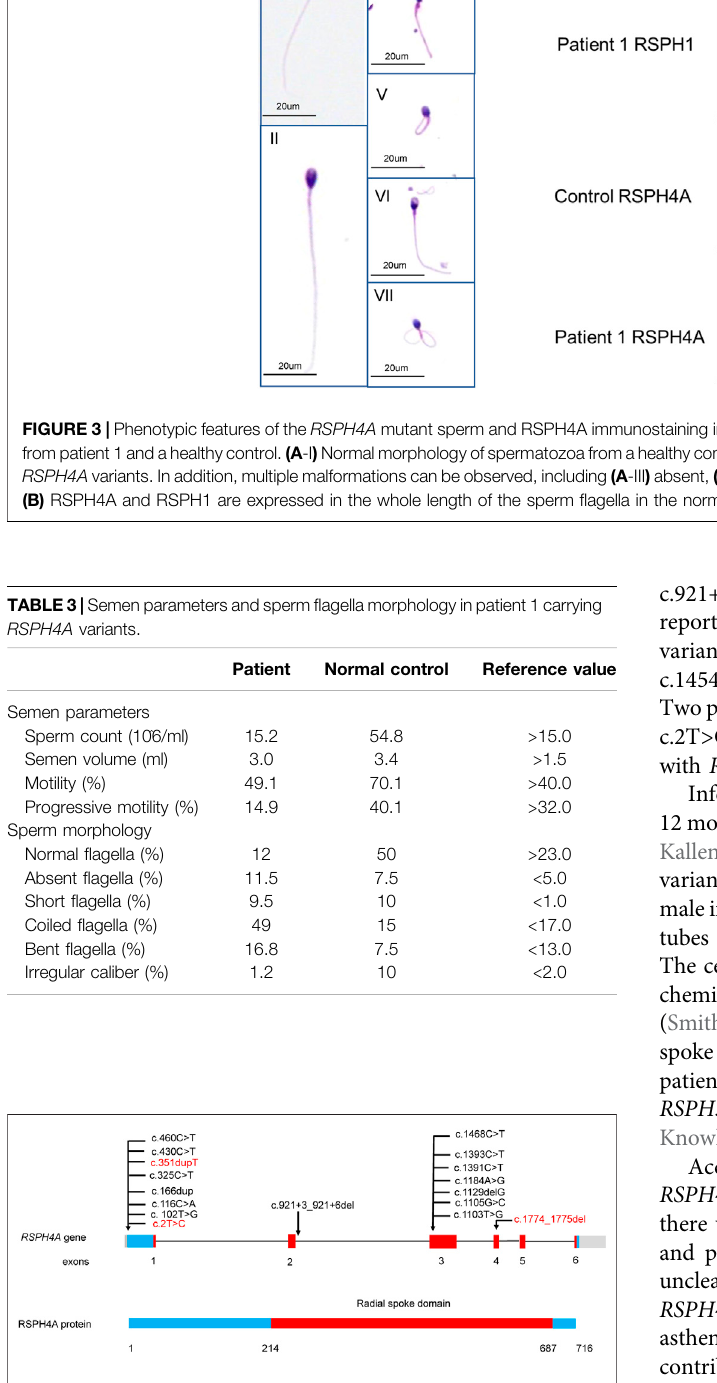
FIGURE 4 | RSPH4A gene and protein structure and the reported disease-causing variants of RSPH4A . Domains and their relative exons were fi lled using the same colors. Variants in our study were highlighted using red.